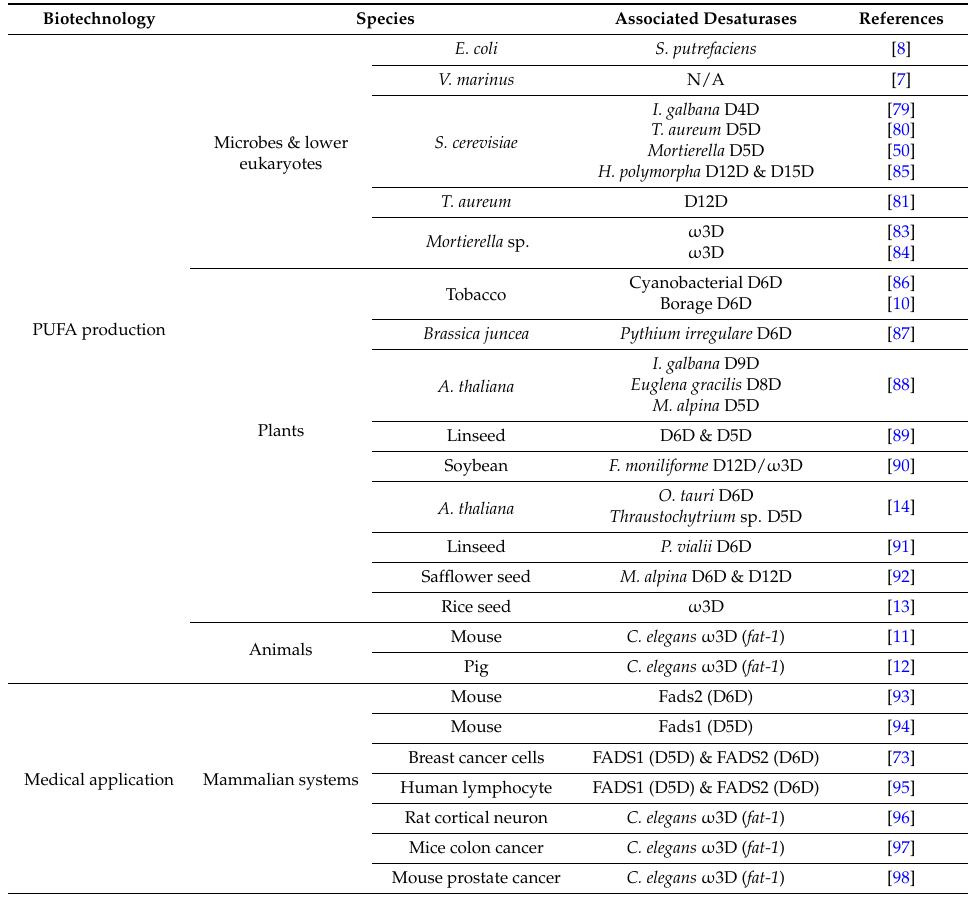
Table 1. PUFA biotechnology and desaturases of different